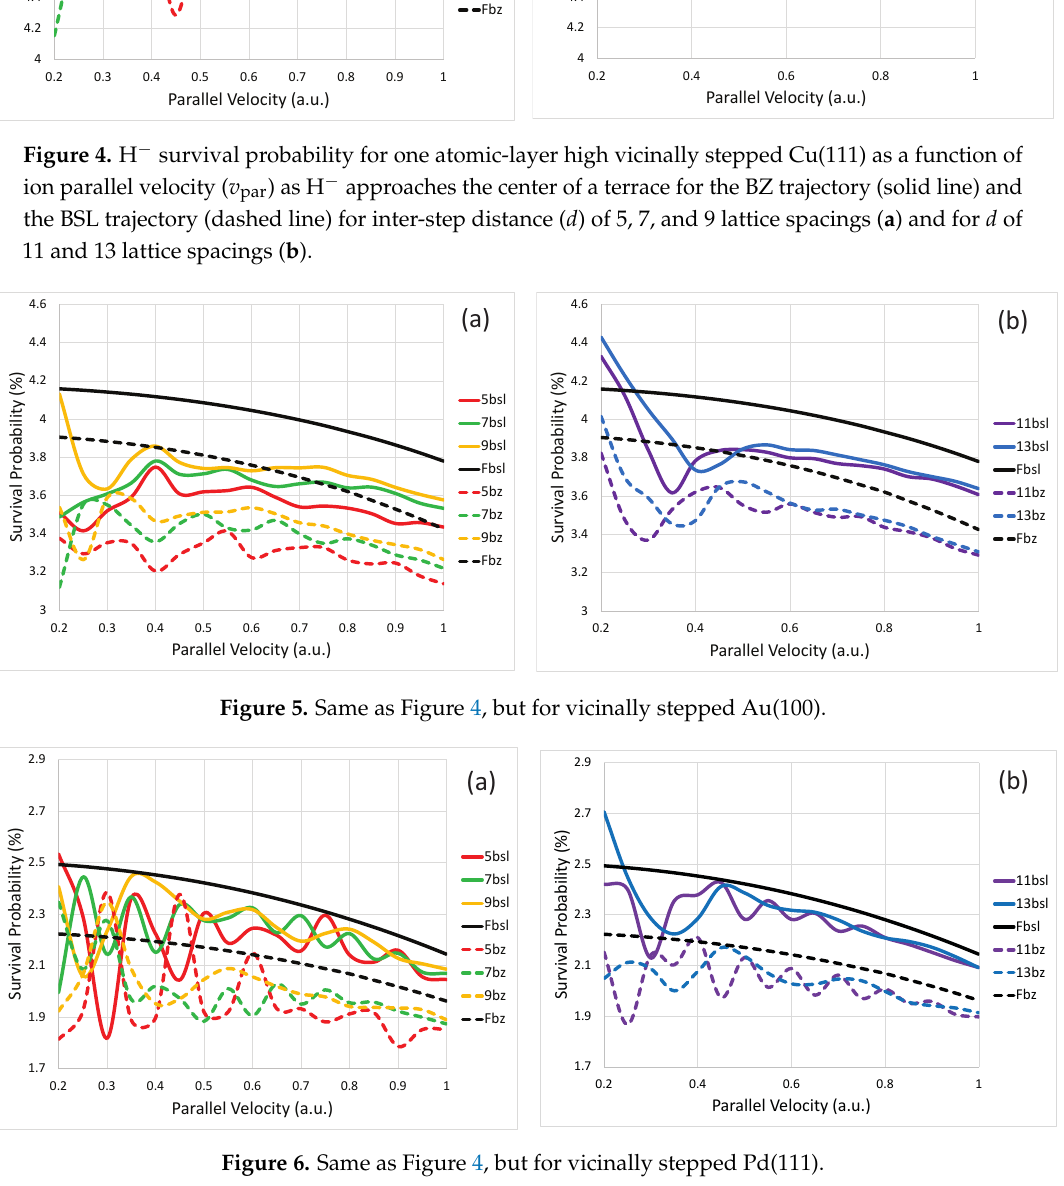
Figure 6. Same as Figure 4, but for vicinally stepped